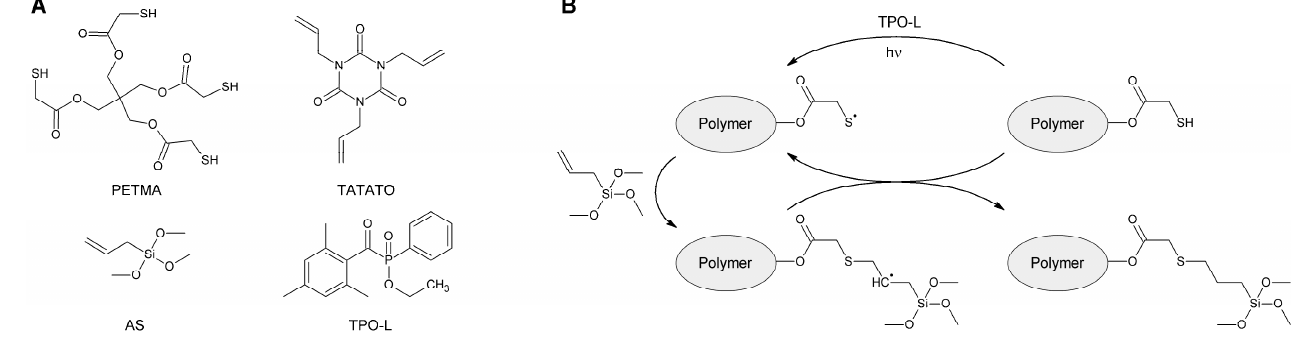
Figure 2. ( A ) Reagents used for the preparation of OSTE-AS polymers. ( B ) Scheme of inclusion of silane fragments into the polymer.